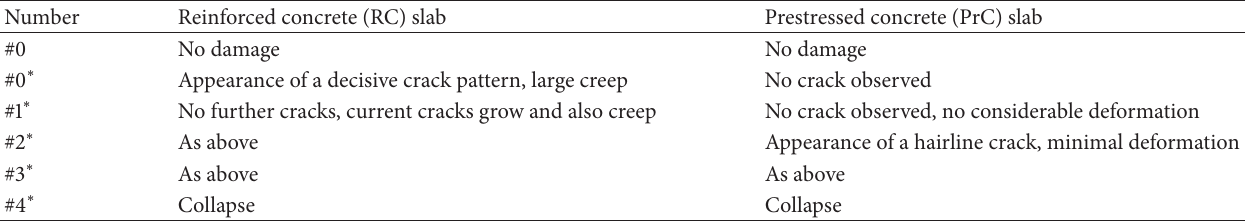
Table 4: Description of damages.